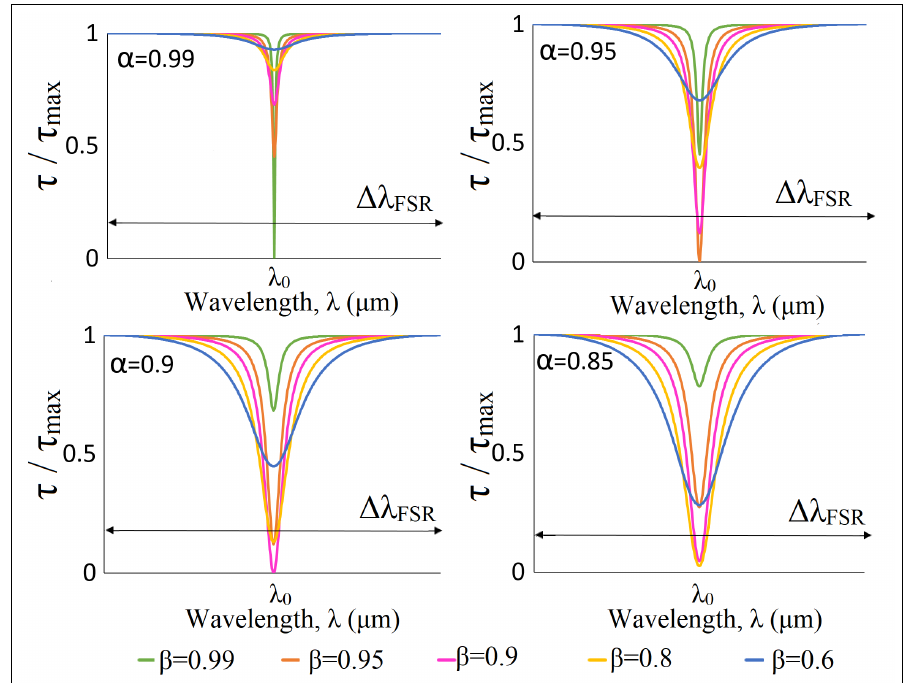
Figure 4. Effect of transmission ( β ) and propagation ( α ) on optical response around the resonant wavelength ( λ 0 ).